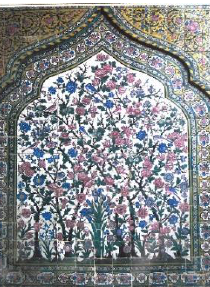
Figure 6. Flower and bird motifs originating from the lower